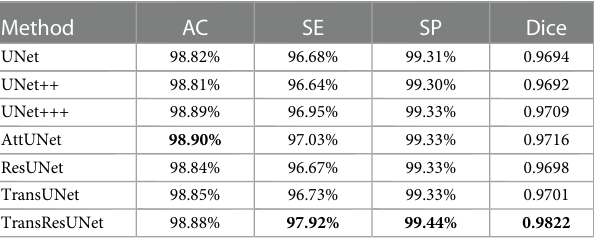
TABLE 1 Quantitative comparisons of the lung segmentation performance in test dataset.